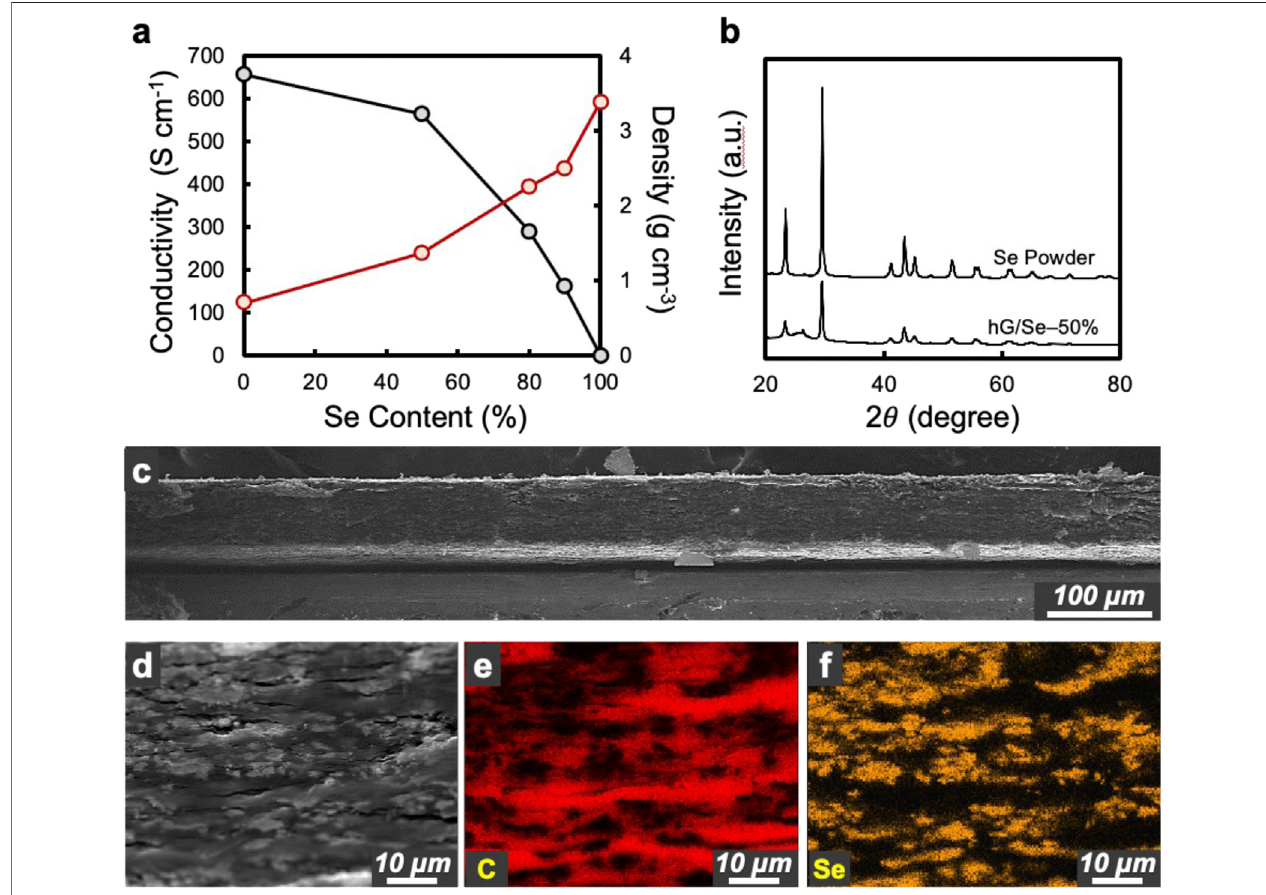
FIGURE2 | Characterizationsof hG/Se cathode discs: (A) dependence of surface conductivity (black color; left axis) and apparent density (red color;right axis) on theSecontent(%)ofvarious hG/Sediscs; (B) XRDpatterns ofhG/Se-50% discsincomparison totheneatSepowder; (C) thelowmagni fi cation SEMimageofacross- sectional view of hG/Se-50% discs; (D) a higher magni fi cation view of the same disc and the corresponding EDS maps of C and Se elements.